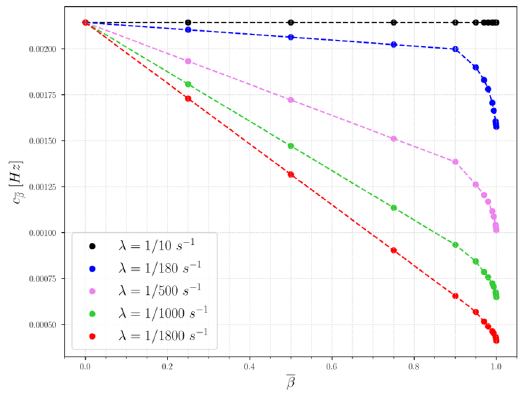
Figure 7. 𝑐 (cid:3081)(cid:3365) for 𝛼 = 0.9 , 𝐴𝑜𝐼 (cid:3080) = 420 s , 𝜆 = 1 (cid:3403) 10 s (cid:2879)(cid:2869) , 𝜆 = 1 (cid:3403) 180 s (cid:2879)(cid:2869) , 𝜆 = 1 (cid:3403) 500 s (cid:2879)(cid:2869) , 𝜆 = 1 (cid:3403) c for α = 0.9, AoI α = 420 s, λ = 1/10 s − 1 , λ = 1/180 s − 1 , λ = 1/500 s − 1 , β 1000 s (cid:2879)(cid:2869) , and 𝜆 = 1 (cid:3403) 1800 s (cid:2879)(cid:2869) . λ = 1/1000 s − 1 , and λ = 1/1800 s − 1